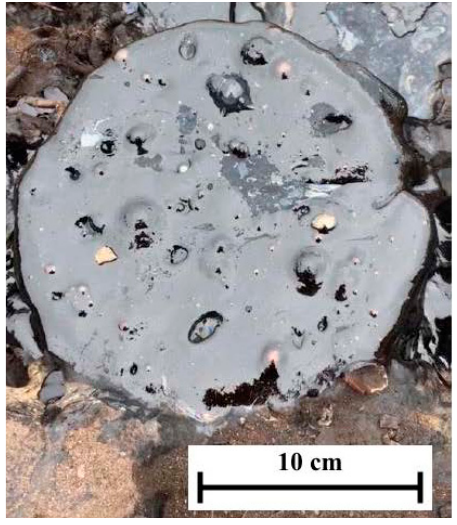
Figure 5. Exposed pipe with bubbling asphalt that was sampled at Carpinteria.